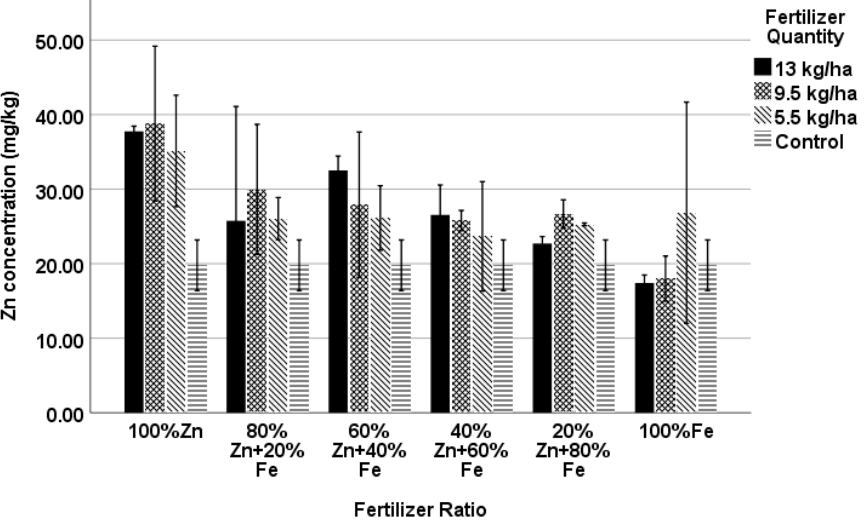
Figure 4. Effect of foliar application of combined Zn and Fe fertilizers on wheat grain Zn concentration. Values plotted are means of two copping seasons. Vertical bars represent the 95% confidence interval.